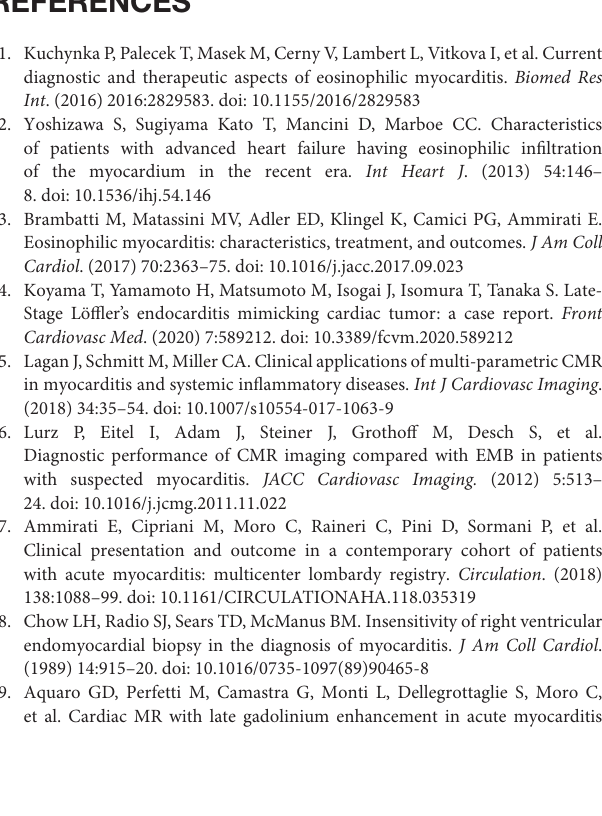
Supplementary Figure 1 | Timeline of the case. Echo, echocardiography; EF, ejection fraction; ECG, electrocardiogram; LV, left ventricle; LVOT-VTI, left ventricular outflow tract-velocity time integral; IABP, intra-aortic balloon pump.